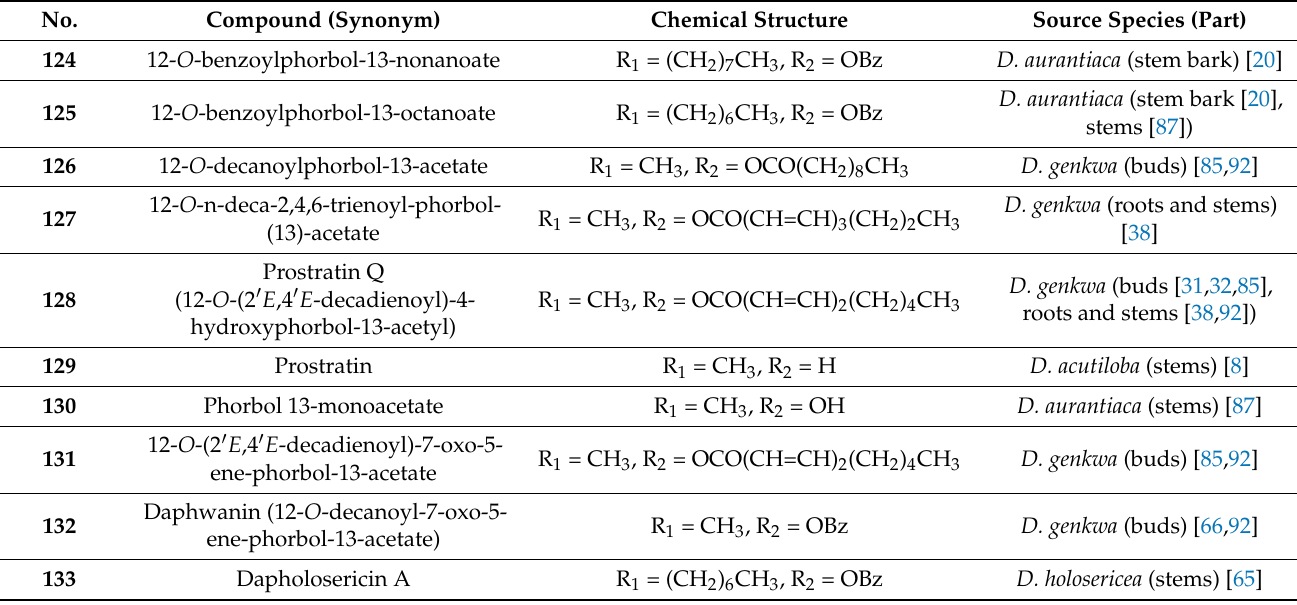
Table 7. Structures and sources of tigliane-type diterpenoids ( 124 – 133 ).